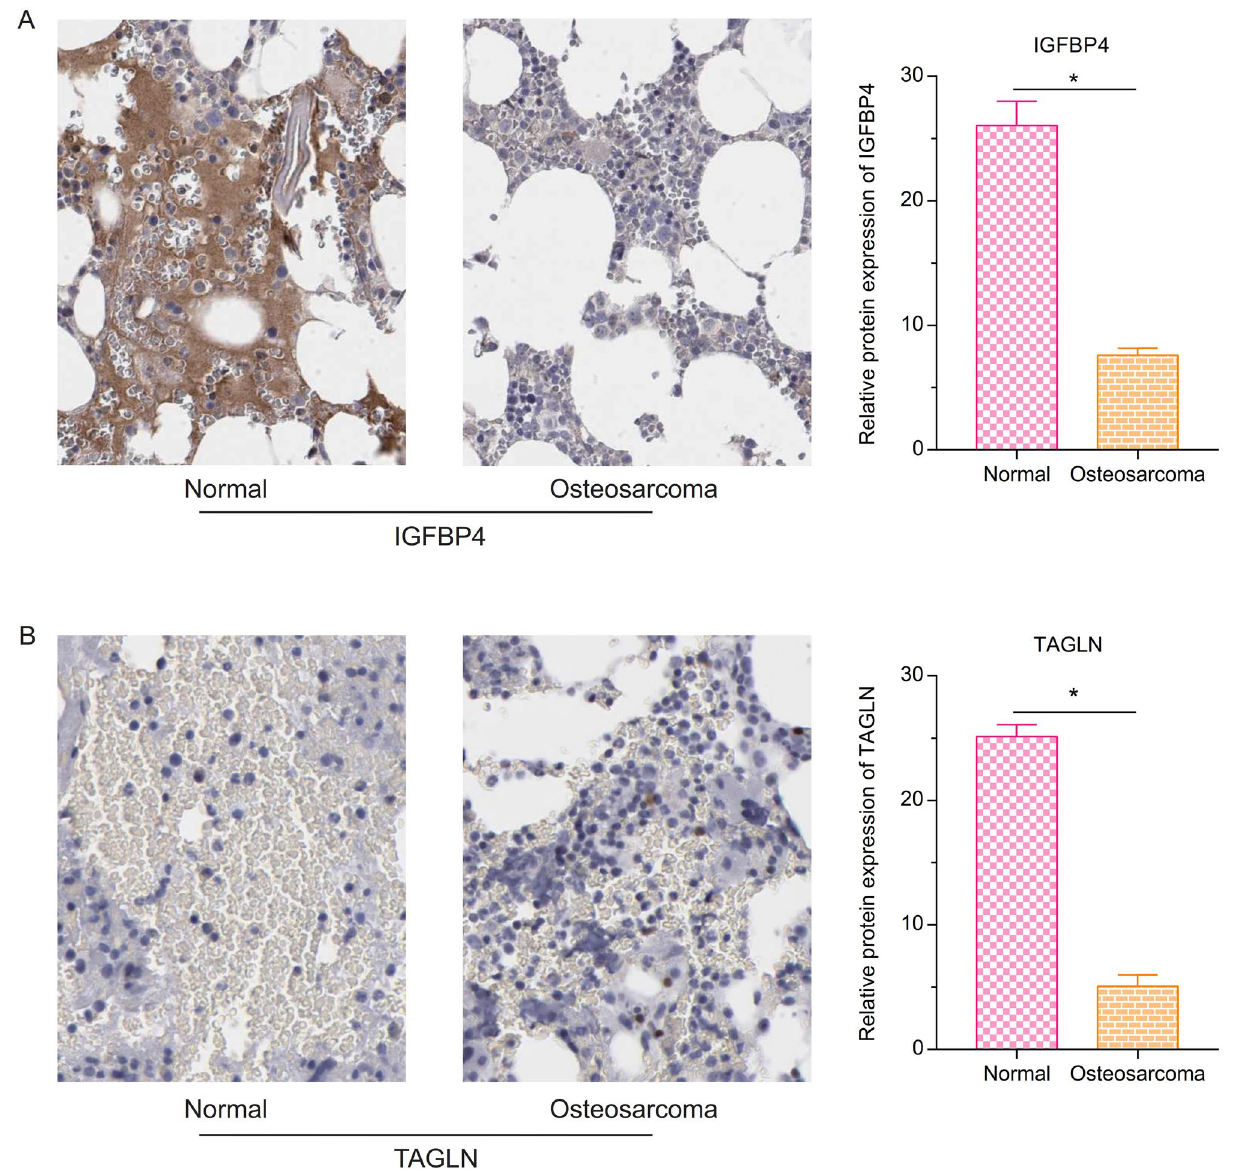
Figure 8. The protein expression of IGFBP4 and TAGLN in the osteosarcoma by the Human Protein Atlas. ( A ) Protein expression of IGFBP4 in the osteosarcoma was lower than the normal. ( B ) The protein expression of TAGLN in the osteosarcoma was lower than the normal (*P <